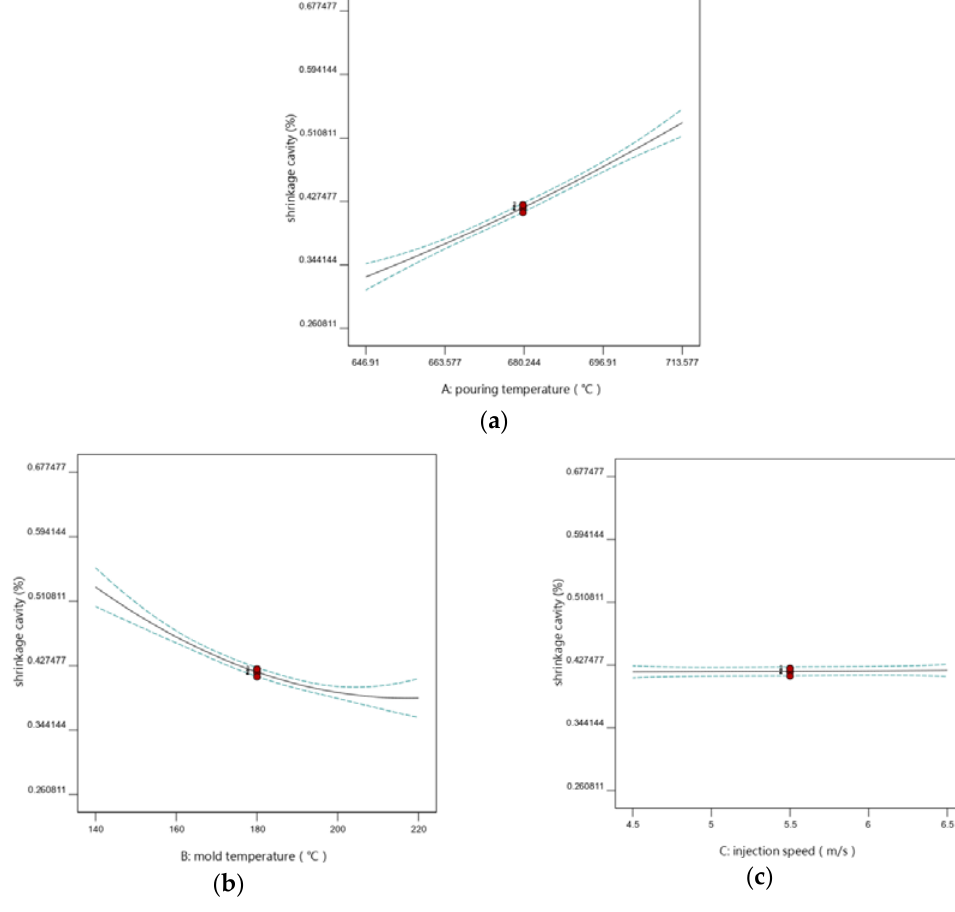
Figure 6. Effect of single factor on shrinkage cavity rate (Y 2 ).